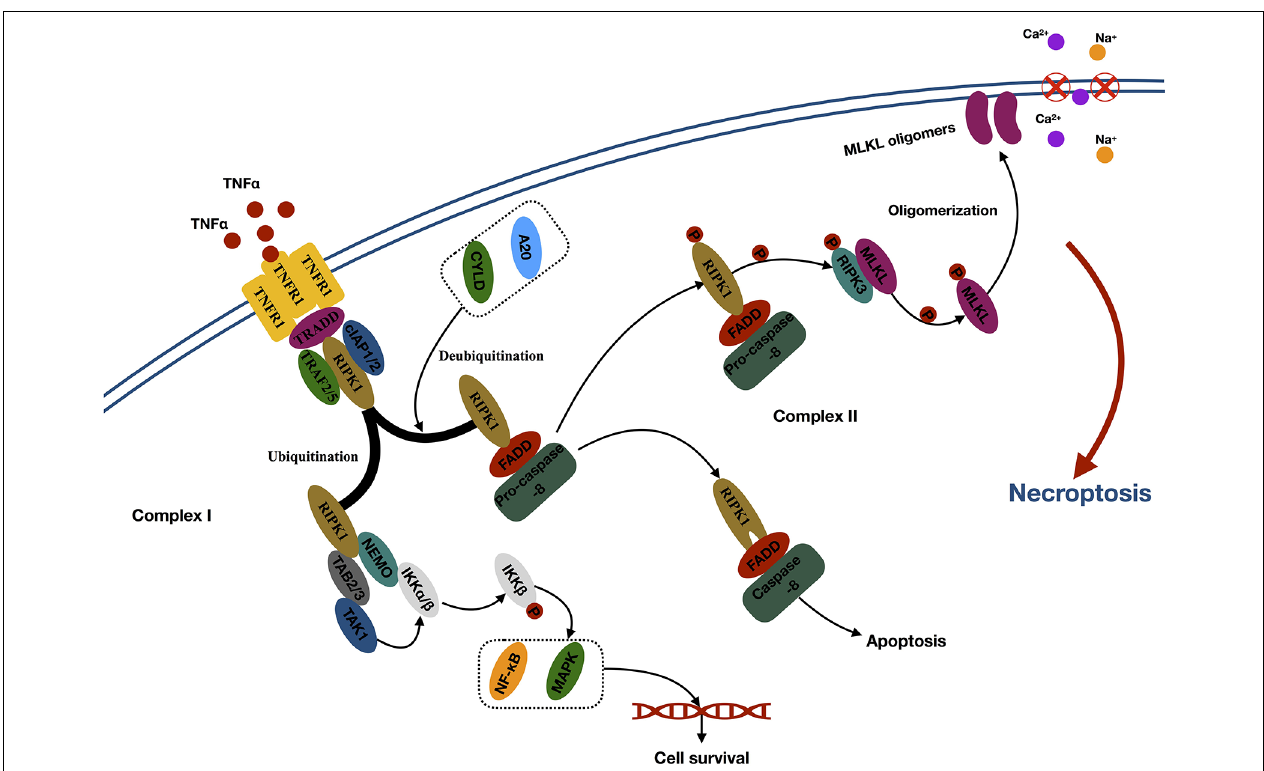
FIGURE 1 | Mechanisms of necroptosis. Abbreviations: TNF α , tumor necrosis factor; TNFR1, tumor necrosis factor receptor type 1; TRADD, TNF α receptor-associated death domain; TRAF2, TNFR-associated factor 2; cIAP1, cellular inhibitor of apoptosis 1; RIPK1, receptor-interacting kinase 1;